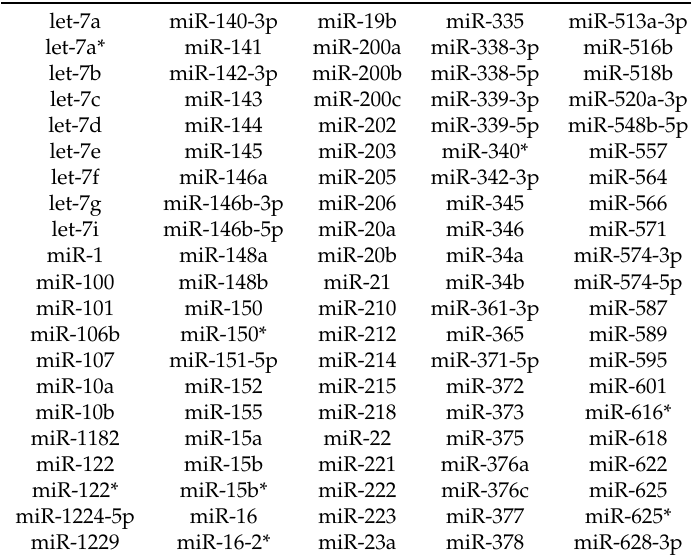
Table A1. List of all circulating